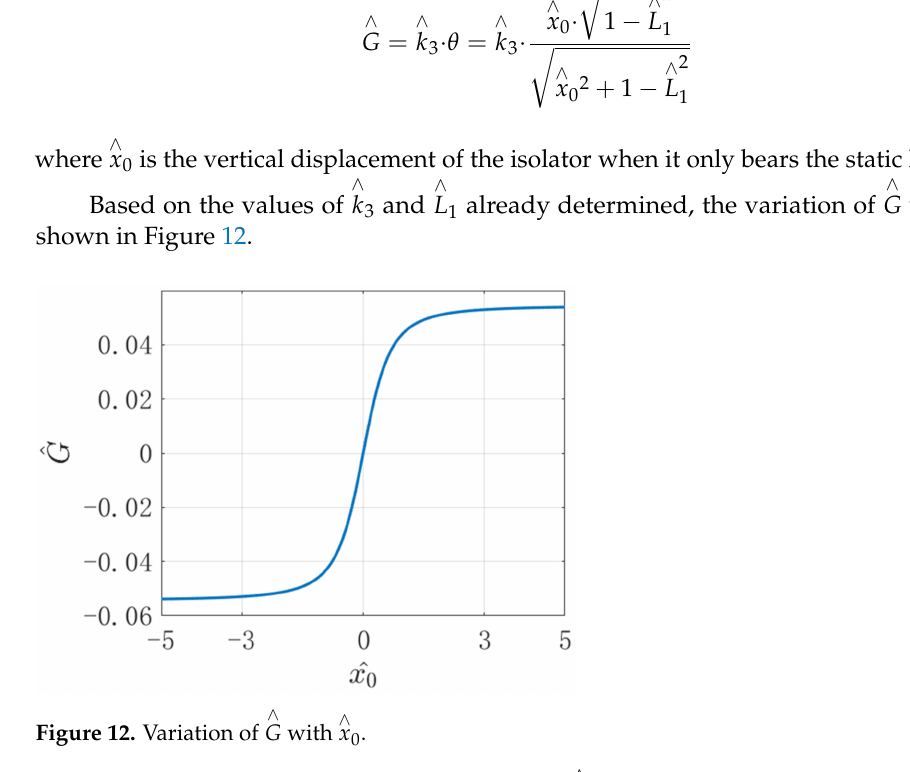
Figure 12. Variation of